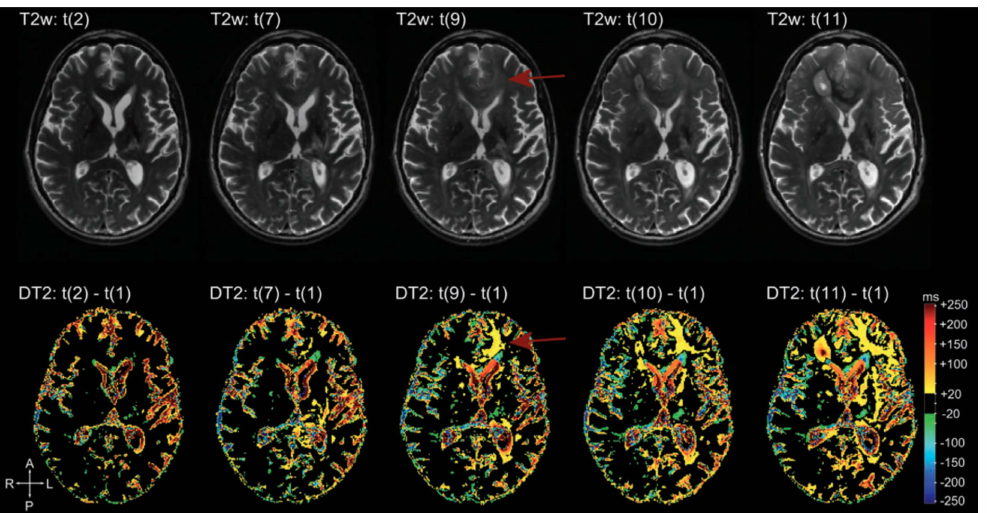
Figure 17. Example of T2 subtraction maps at different time points during follow-up. Upper row: T2 images at different time points. Lower row: T2 subtraction maps (with reference to time point one, not showed) at the same time points. T2 subtraction maps sharpen the evolution of T2 signal during time, hardly visible at the beginning on conventional T2 images (difference more evident at time point 9, red arrow)